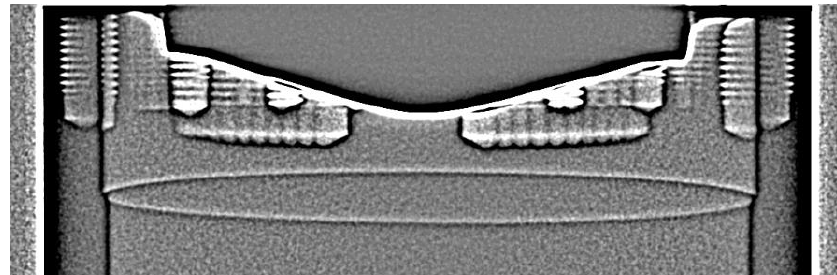
Figure 11. In situ setup of the crucible scanned at 125 kV and no pre-filter. None of the patterns affect the image due to the filtering effect of the crucible walls. the image due to the filtering e ff ect of the crucible